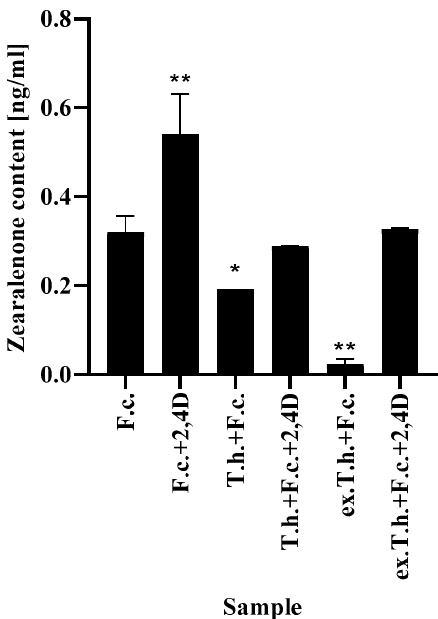
Figure 7. The ZEA levels in filter paper after 7 days of cultivation (T.h.— T. harzianum -inoculated wheat seeds; F.c.— F. culmorum -inoculated wheat seeds; ex.T.h.— T. harzianum extracellular metabolite- treated wheat seeds). Data represent means ± SE; the significance of the variance study with Tukey’s post hoc test = * p ≤ 0.01, ** p ≤ 0.001. The subcolumn statistic comparison is attached in supplementary material as Table S7.